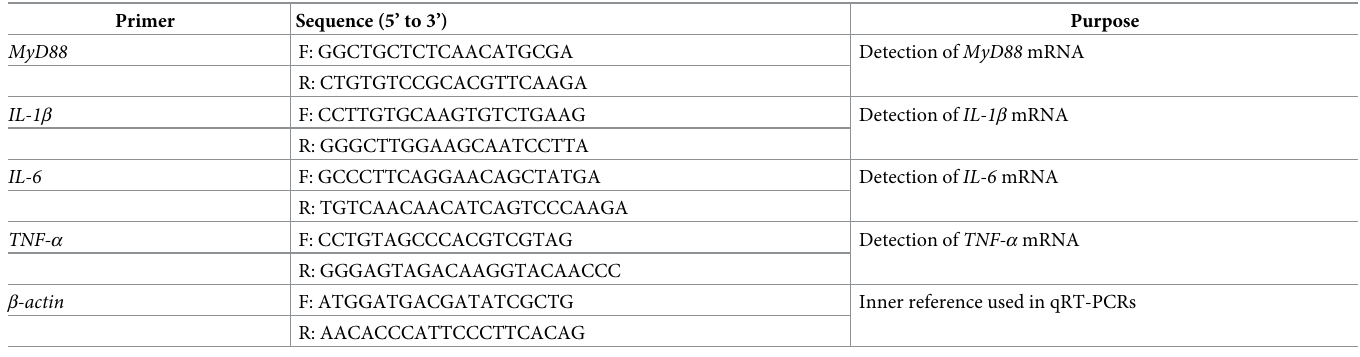
Table 1. Primers used in this